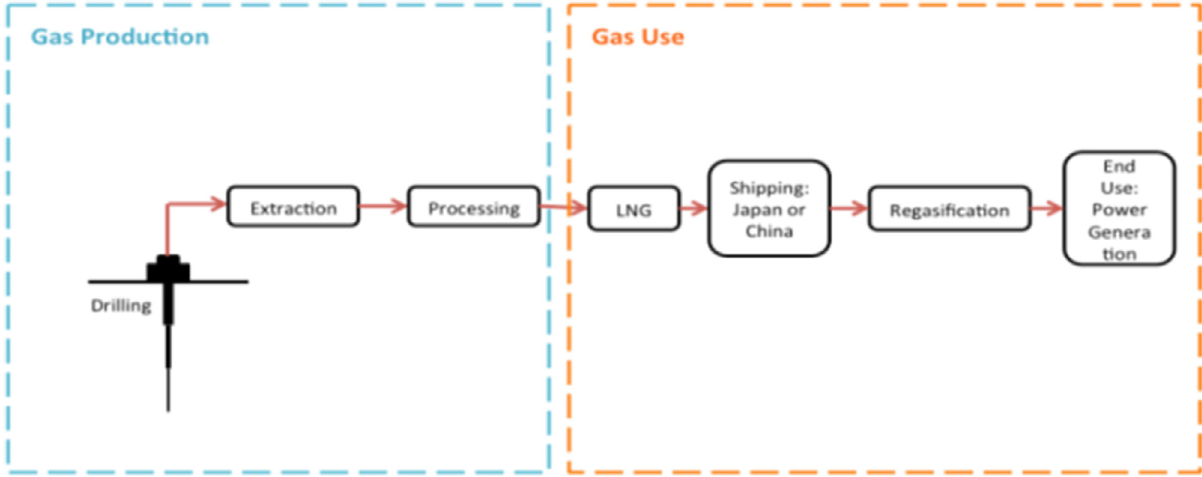
Fig. 3. Separation of shale gas life cycle into two sections (Goldstein et al. 2012).